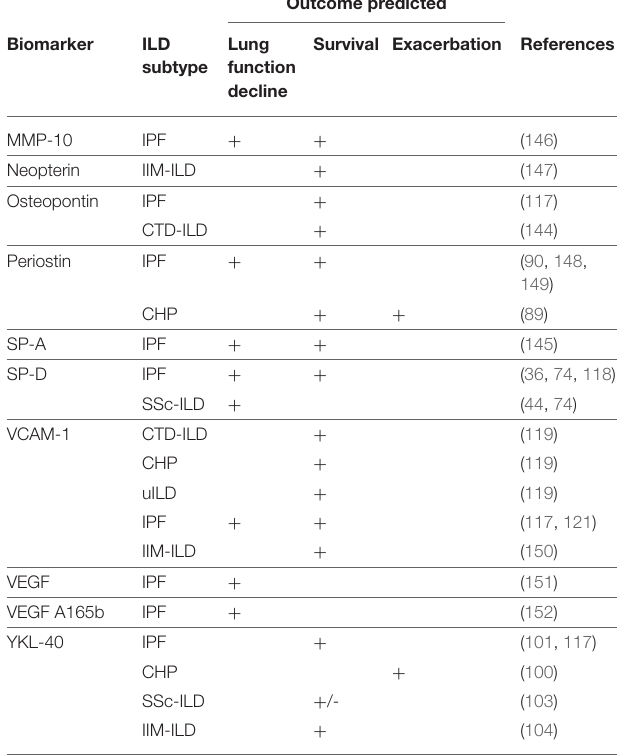
TABLE 2 | Prognostic ILD plasma/serum biomarkers. Outcome